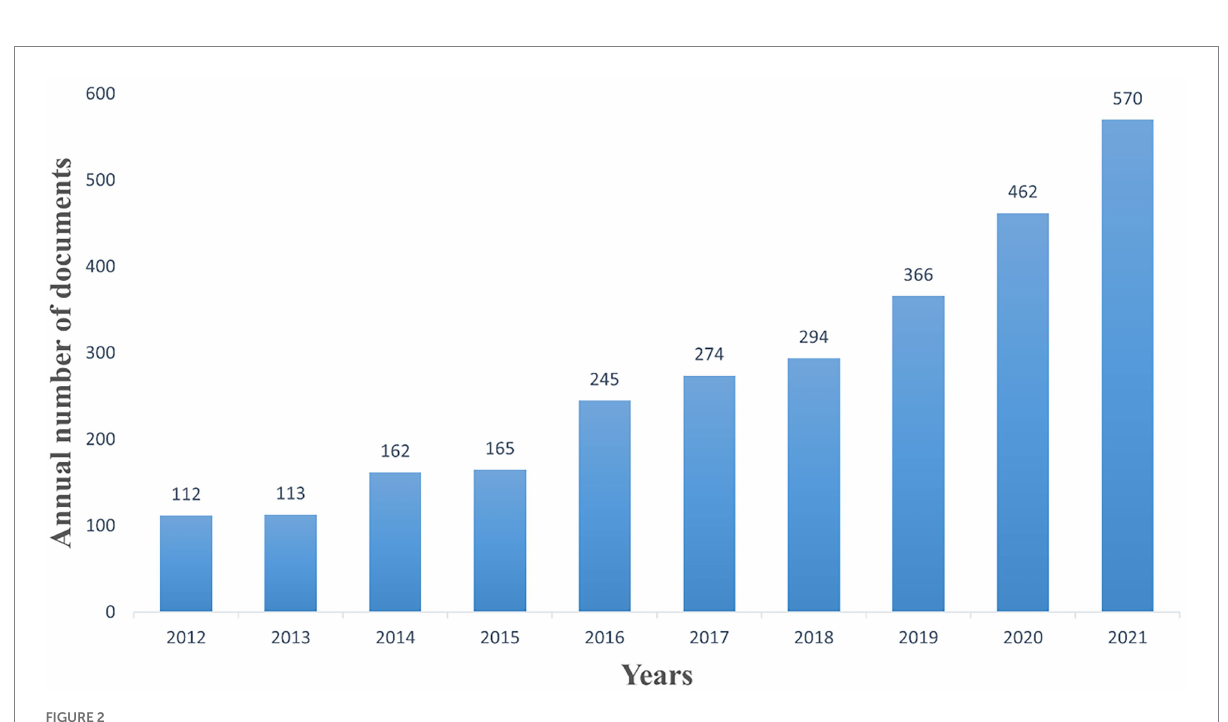
FIGURE 2 Trends in